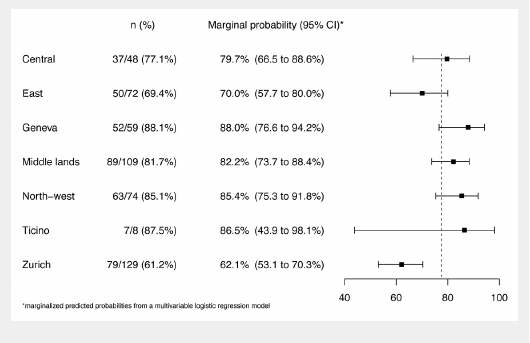
Percentage of participants reporting testing all pregnant women for the indicated disease, by region. BV = bacterial vaginosis; CMV = cytomegalovirus; GBS = group B streptococcus; GO = gonorrhoea; HBV = hepatitis B virus; HCV = hepatitis C virus; HIV = human immunodeficiency virus; HSV = herpes simplex virus.